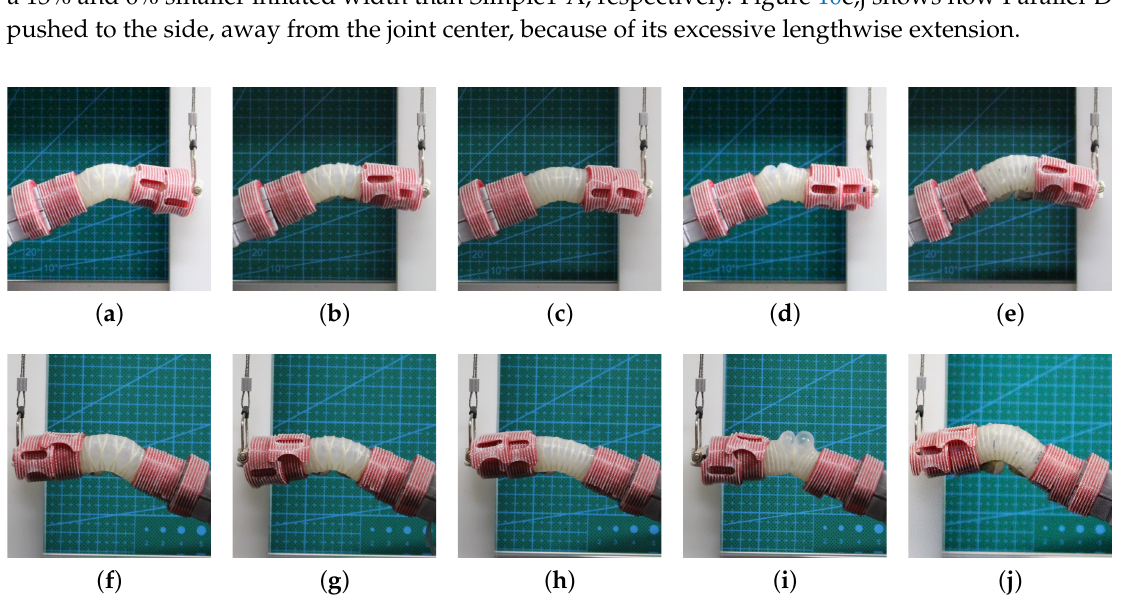
Figure 10. Prototype maximum deformation in 20 ◦ abduction-adduction torque measurement to the right ( a – e ) and to the left ( f – j ); ( a , f ) Simple1-A, 225 kPa; ( b , g ) Simple2-A, 225 kPa; ( c , h ) Simple2-B, 225 kPa; ( d , i ) Opposing-C, 175 kPa/125 kPa. Photos were taken at the end of the measurements, when the right side pockets’ ballooning had become excessive; ( e , j ) Parallel-D, 175